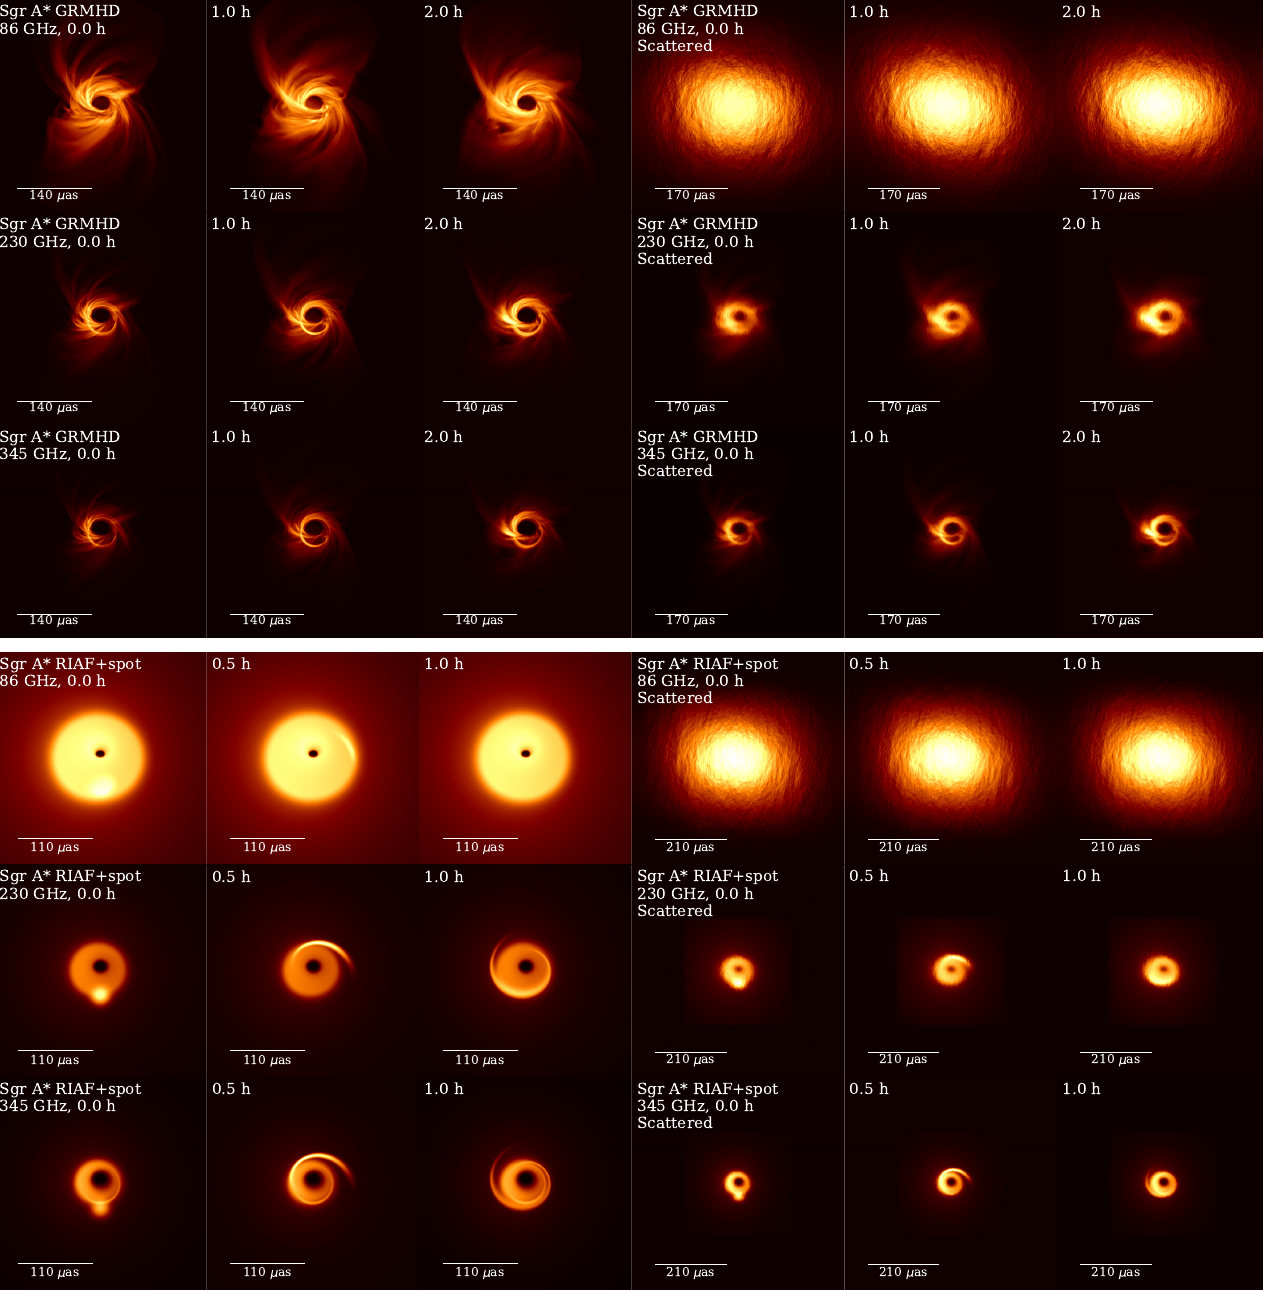
Figure 7. Ground truth Sgr A* source models used for Challenge 2. For each model and frequency (rows), three movie frames (columns) are shown, with interstellar scattering applied to the first frame in the rightmost column. Images are shown on a square root scale, which is normalized to the brightest pixel value across each set of three movie frames. The scattered movies were used as inputs for the Challenge 2 synthetic data